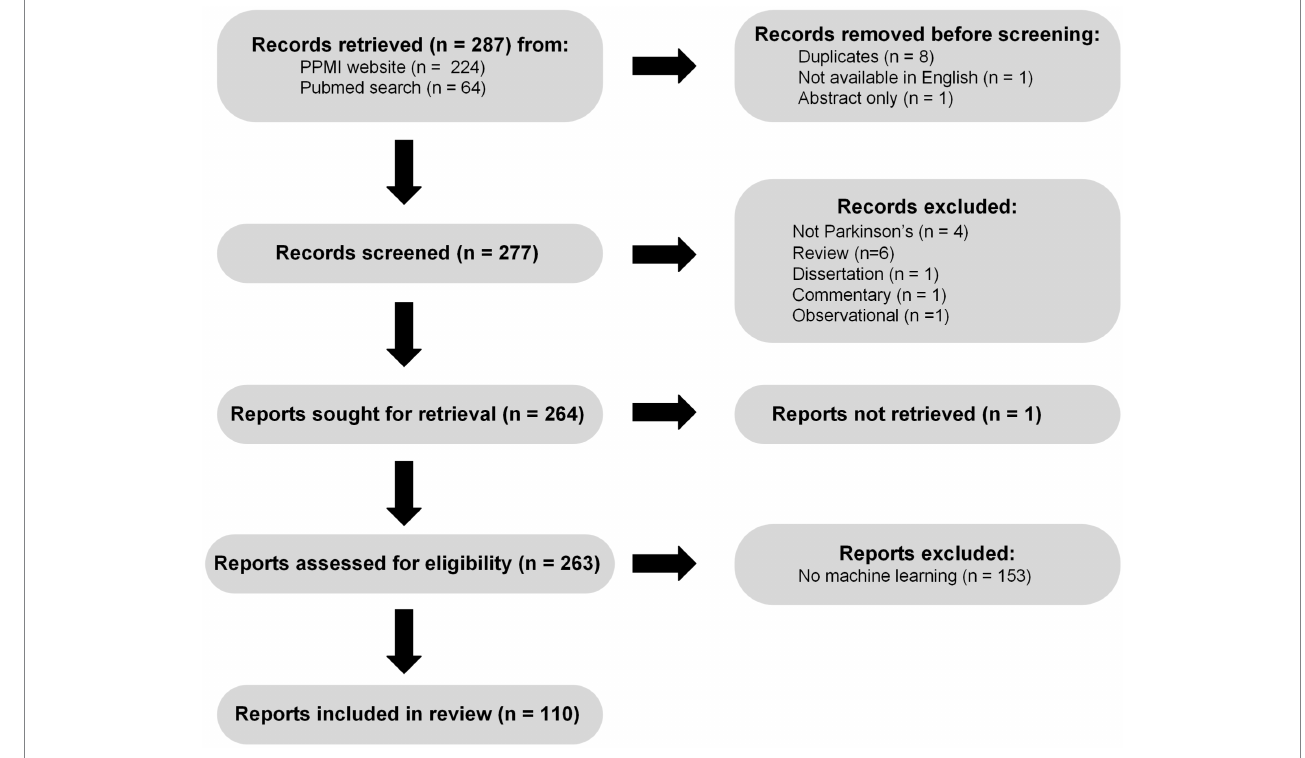
FIGURE 1 PRISMA (Page et al., 2021) flow chart illustrating the process of searching for, screening, and assessing machine learning PPMI